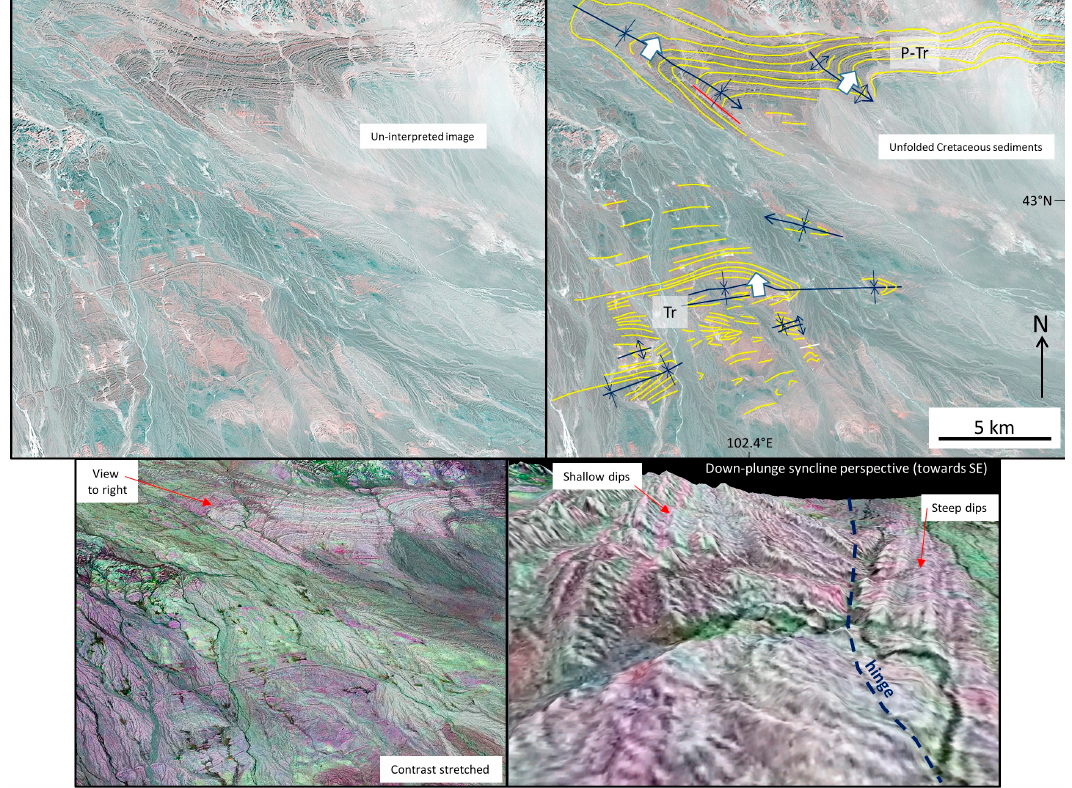
Figure 4. Un-interpreted and interpreted Landsat TM (M48-40_2000 MrSID) image showing bedding traces (yellow lines) and major fold hinges in folded Permian-Triassic rocks (P-Tr), SE Noyon Uul region, southwest Mongolia. Thick white arrows indicate direction of fold vergence. Lower left image shows contrast enhanced image with better discrimination of folded layers (Global Mapper Color Blend Mode-Difference tool). Lower right image shows 3D perspective looking down plunge towards the southeast of asymmetric northeast vergent syncline (the southwest limb is steeper than the northeast limb). Vertical exaggeration visually accentuates differences in limb dip and fold asymmetry. See Figure 1 for location.